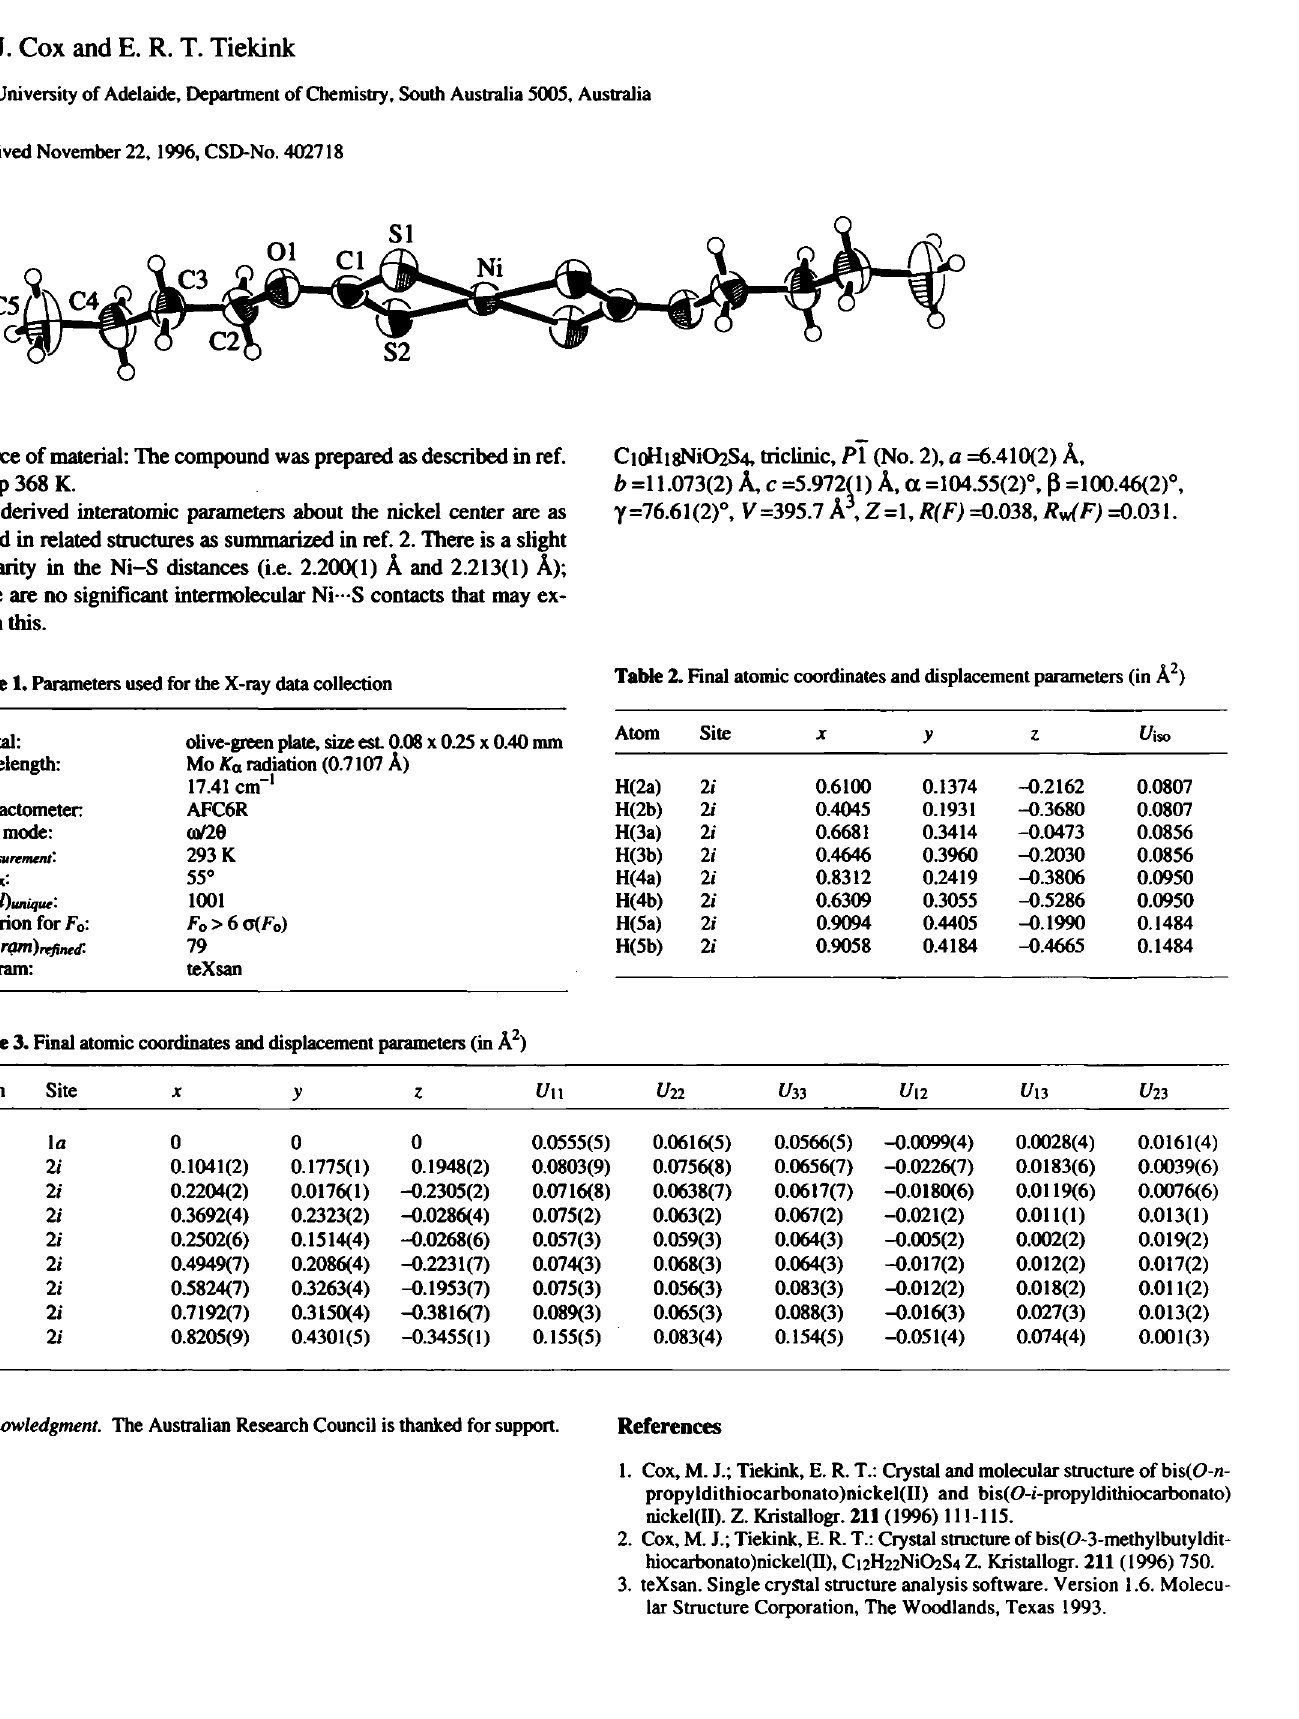
Table 3. Final atomic coordinates and displacement parameters (in Â 2 ) Atom